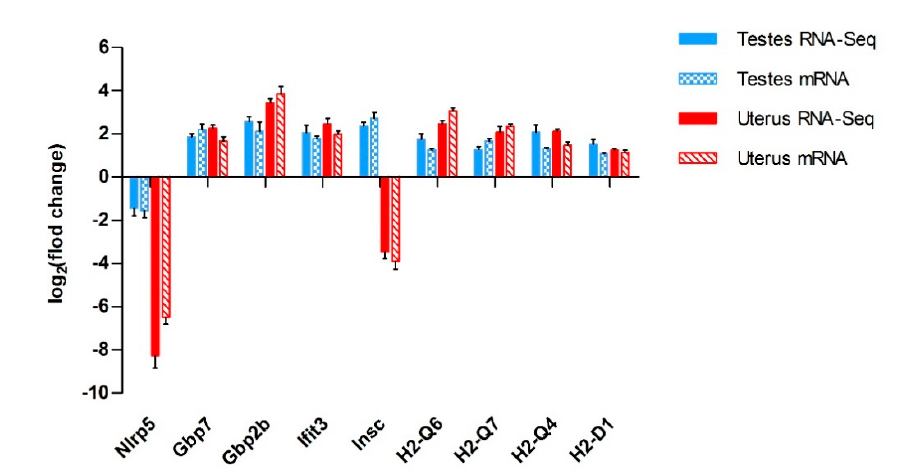
Table 4. Genes in the testes and uterus of infected mice.